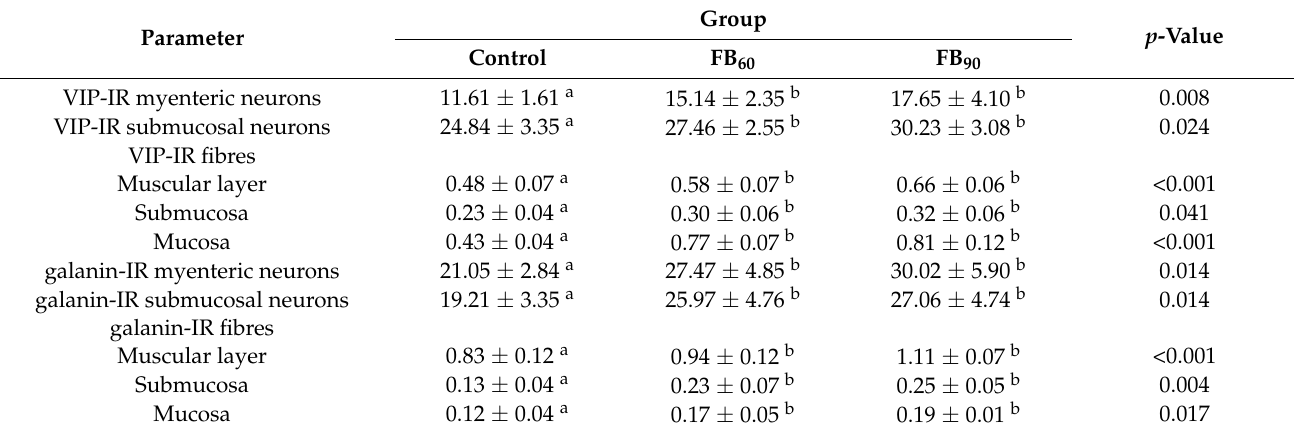
Table 5. Effects of fumonisins intoxication on the chemical coding of the rat duodenal enteric neurons (mean ±